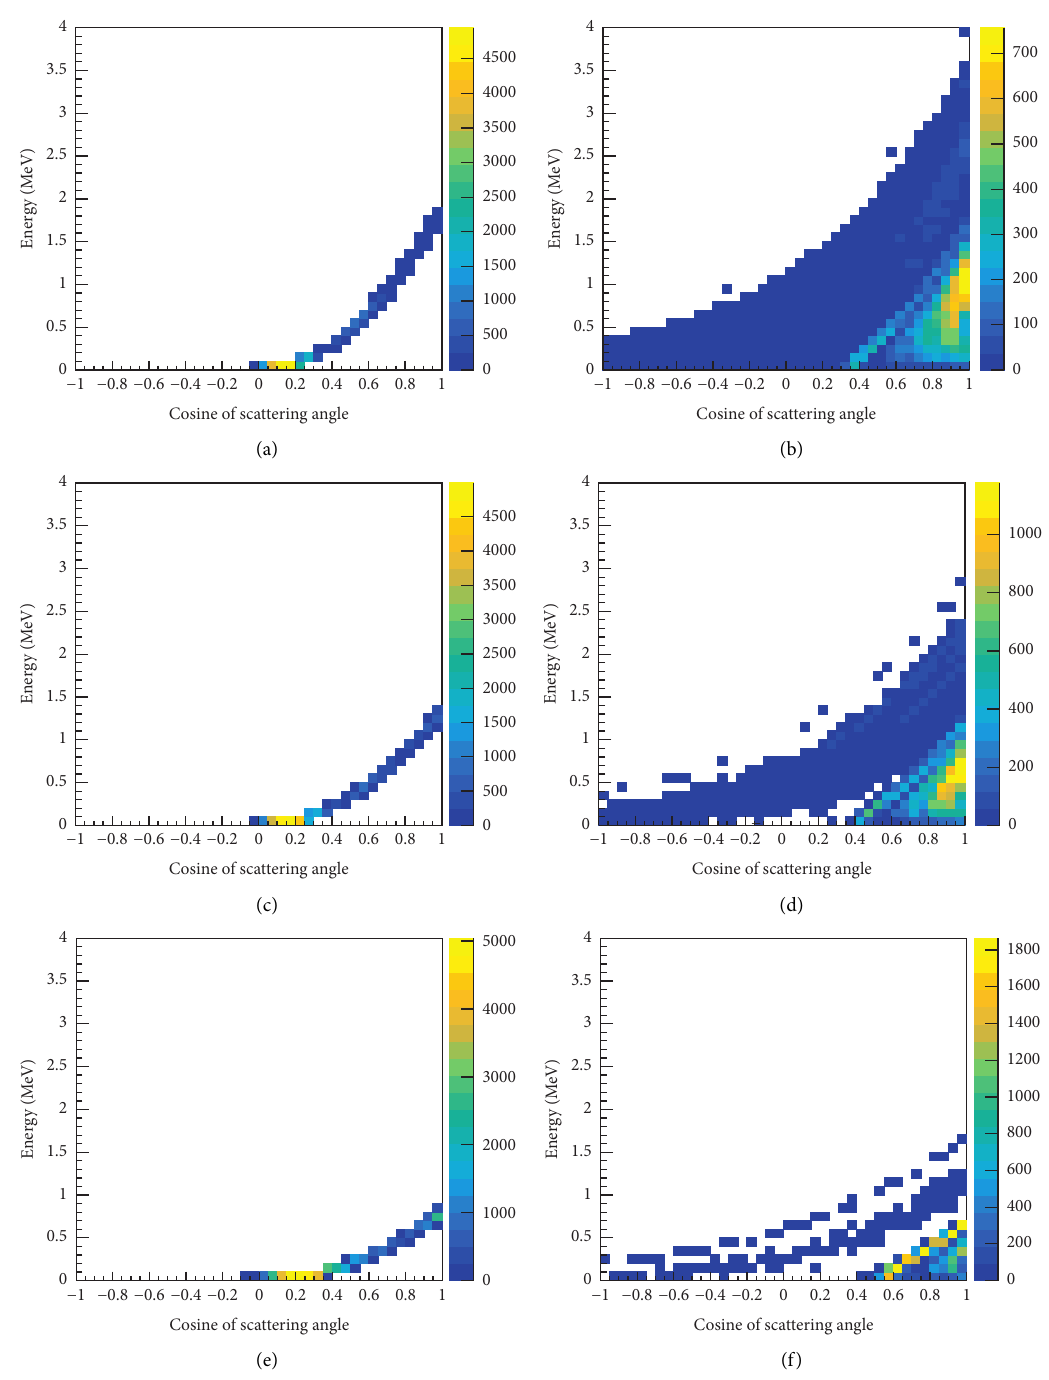
Figure 2: The energy-angular distribution of PKA in the 80 µ m Si thin plate model. (a) Elastic PKAs from 14MeV neutrons. (b) Inelastic PKAs from 14MeV neutrons. (c) Elastic PKAs from 10MeV neutrons. (d) Inelastic PKAs from 10MeV neutrons. (e) Elastic PKAs from 6MeV neutrons. (f) Inelastic PKAs from 6 MeV